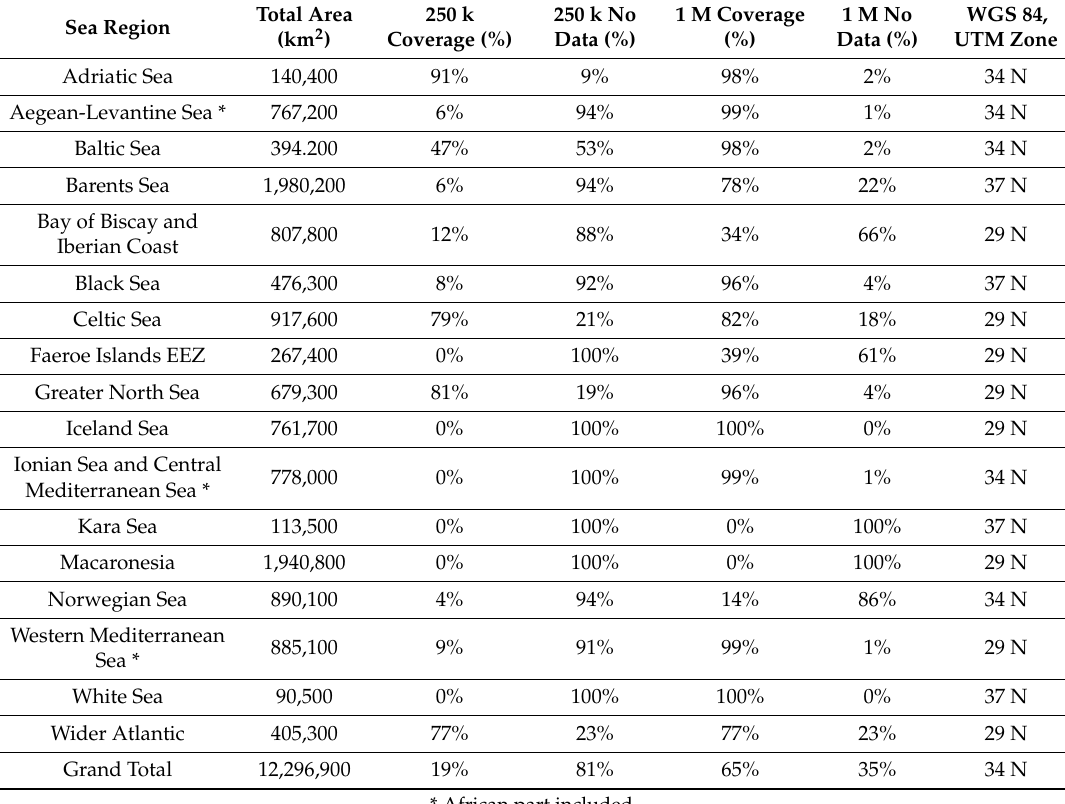
Table 4. Approximate seabed substrate data coverage at different scales versus the extent of the sea region. Sea regions are shown in Figure 1.